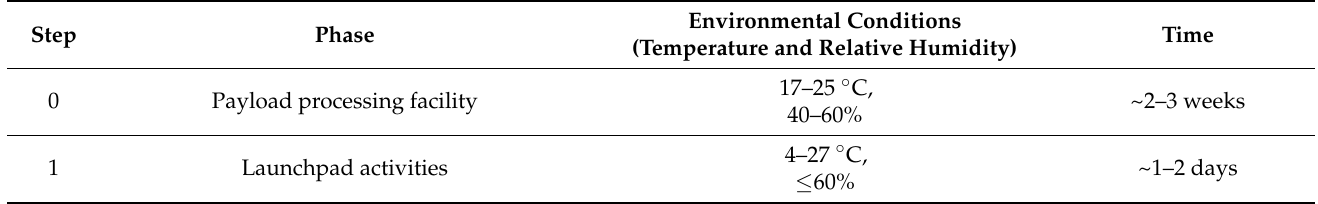
Table 6. Potentially prevailing environmental conditions during the selected steps of the biological nanosatellite mission with a view to our experimentation.